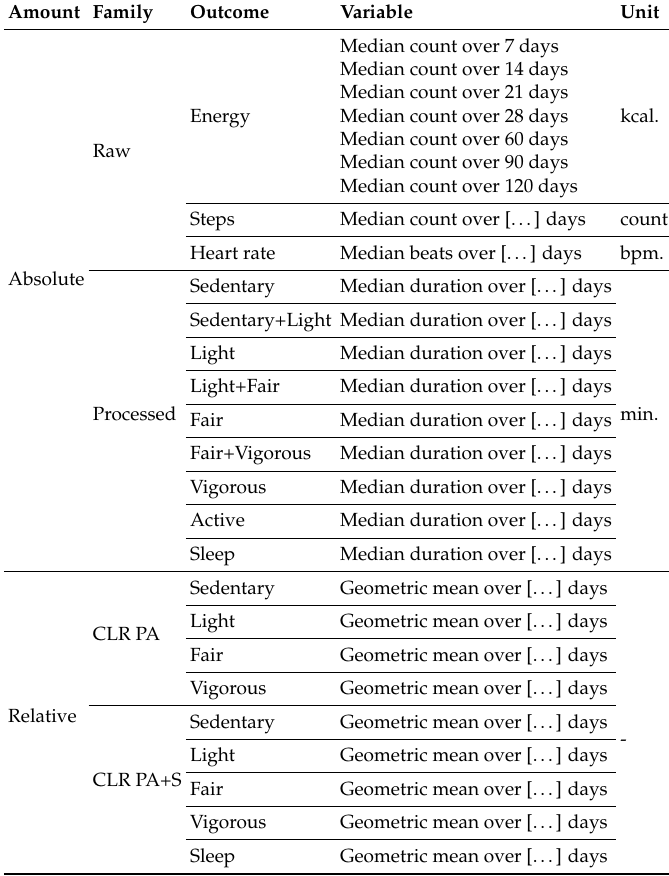
Table 3. Variables derived from the